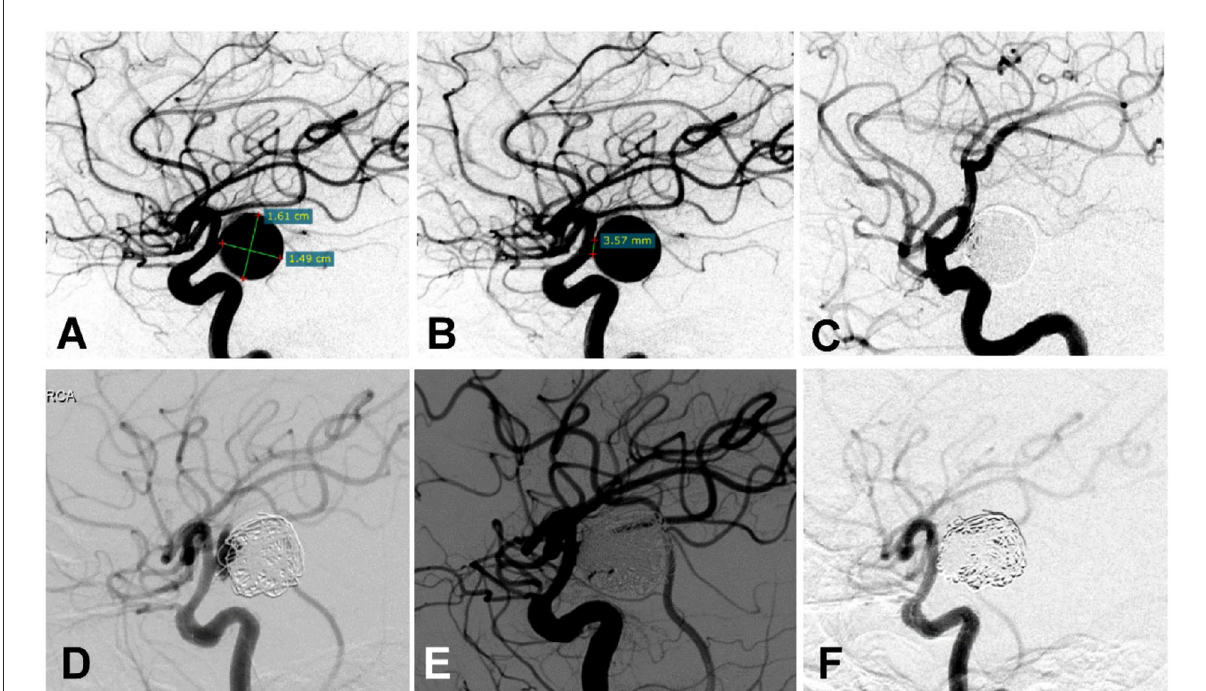
FIGURE2 A woman in her 50s had a posterior communicating artery (Pcom) aneurysm on the right side treated multiple times. (A,B) Cerebral angiography before treatment showed the Pcom aneurysm measuring 16.1 × 14.9mm with a 3.57mm neck. (C) The aneurysm was treated with an Enterprise stent to assist coiling, and the aneurysm was completely occluded immediately after the embolization. (D) Six months later, cerebral angiography revealed recurrence of the aneurysm. (E) The recurrent aneurysm was re-treated with a Low-Profile Visualized Intraluminal Support (LVIS) stent plus coiling, resulting in complete occlusion of the aneurysm immediately at the end of embolization. (F) Six months later, cerebral angiography showed dense embolization without